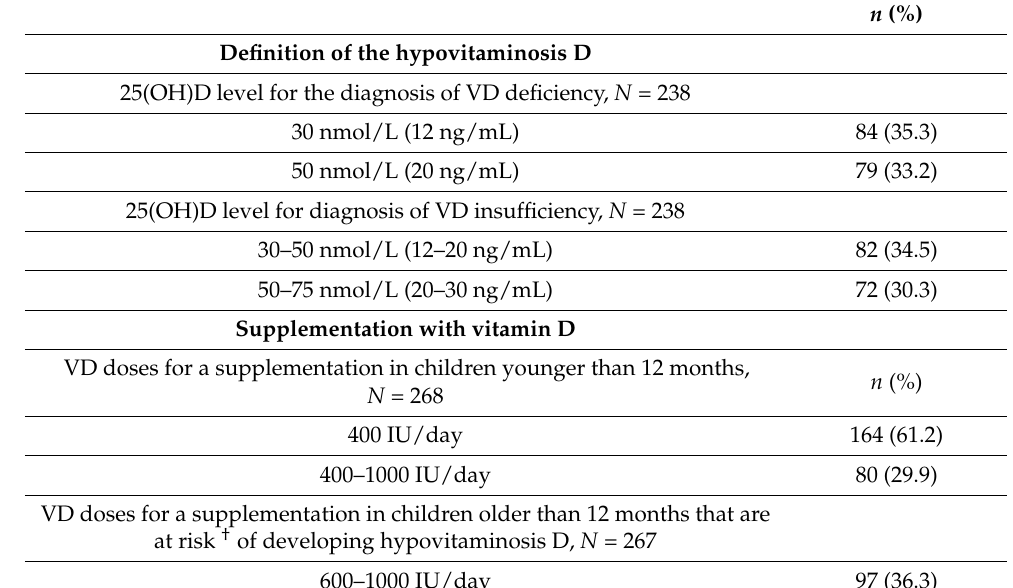
Table 2. Study participants knowledge indicated by percentage of correct answers * regarding diagnosis of hypovitaminosis D, vitamin D supplementation and